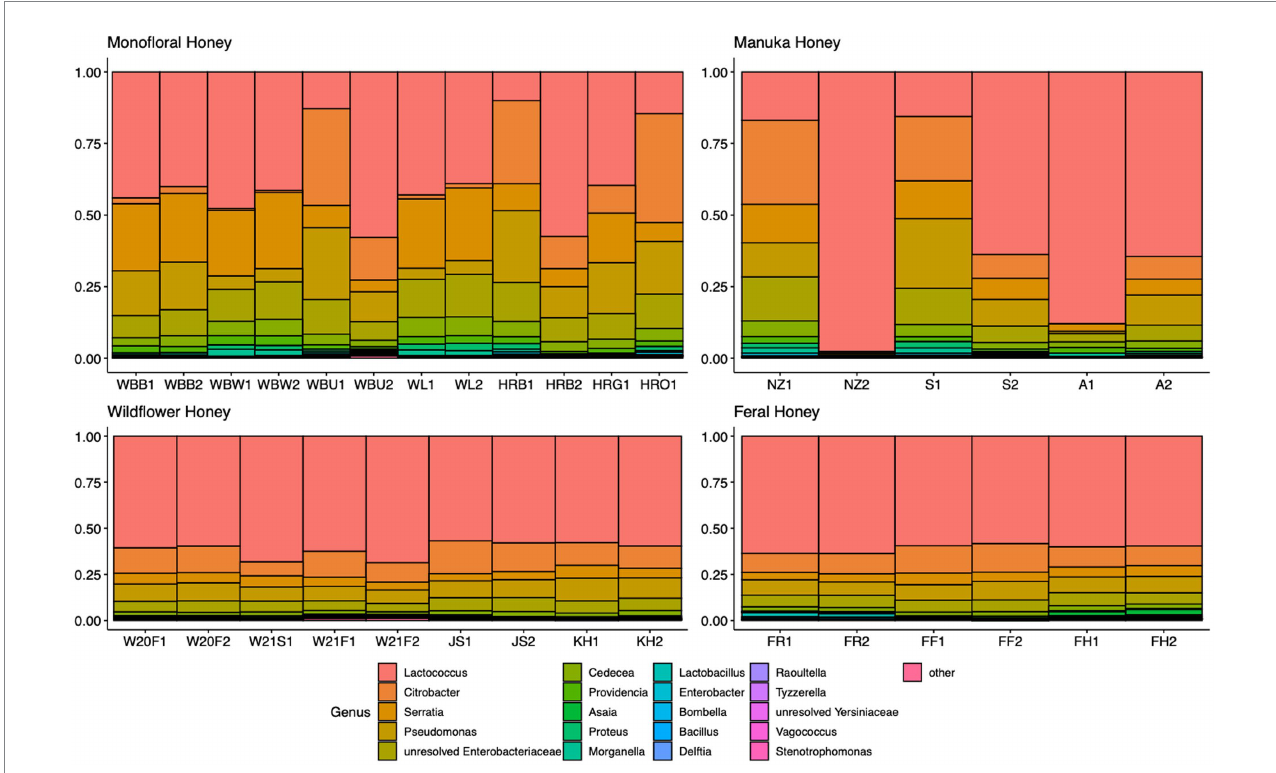
FIGURE 1 Honey bacterial composition plot. 16S ASVs were agglomerated to the genus level for each honey sample. Genera with relative abundance higher than 0.05% across samples were selected and plotted. Genera with less than 0.05% were agglomerated as